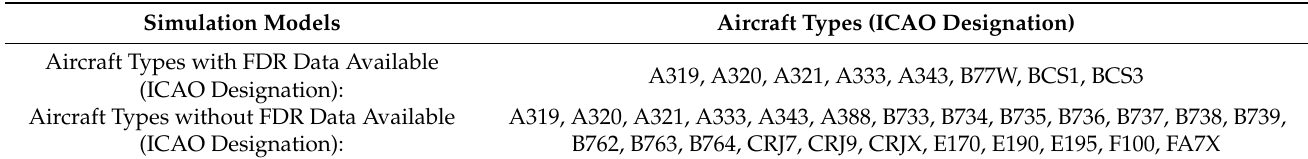
Table 1. Simulated aircraft types with and without FDR data available. For several aircraft types, both cases occurred. Simulation Models